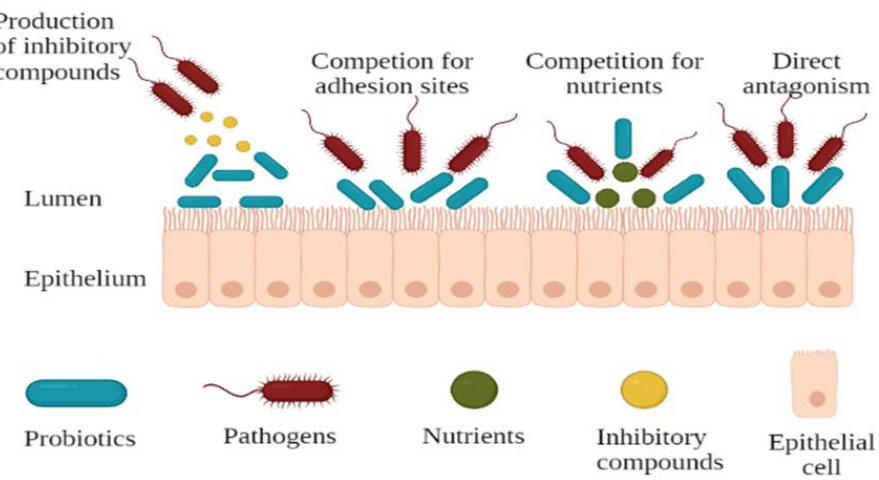
Figure 2. Mechanisms of pathogen inhibition by probiotics.